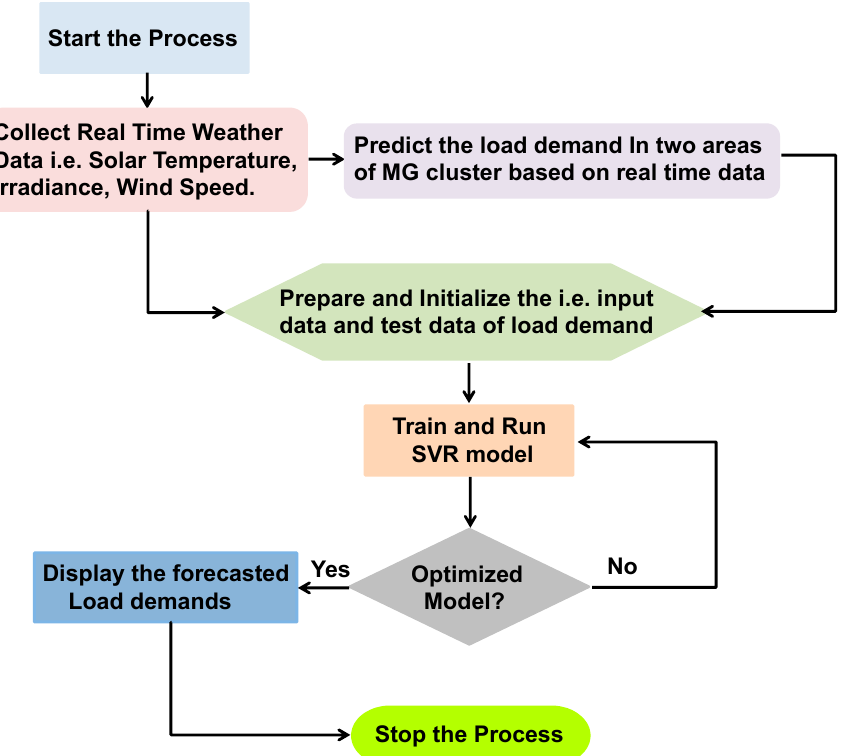
Figure 4. Flowchart for implementing support vector machine model.